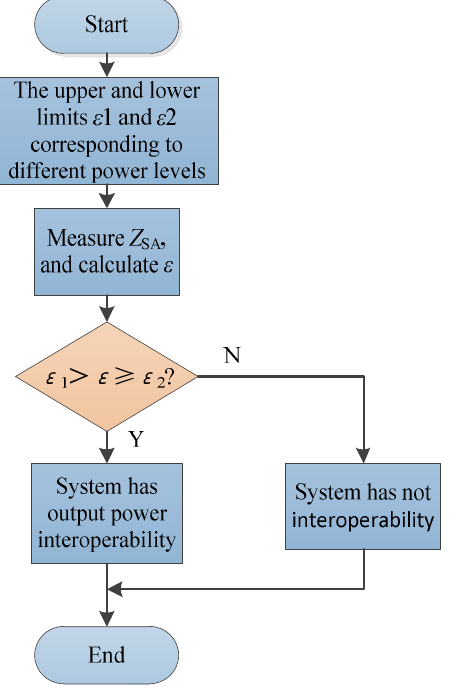
Figure 8. Flow chart of output power interoperability evaluation of electric vehicle WPT system.